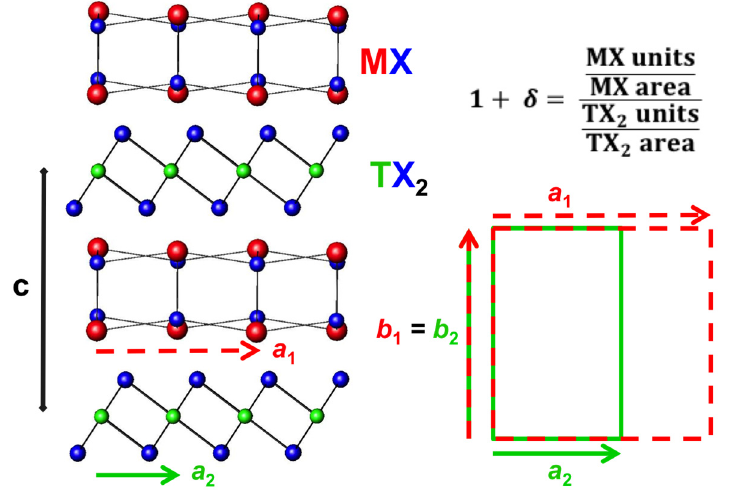
Figure 3. Structural summary of misfit layer compounds. General Superlattice structure ( left ) with in-plane lattice depiction ( bottom right ) and calculation of misfit parameter based on difference in in-plane packing density ( top right